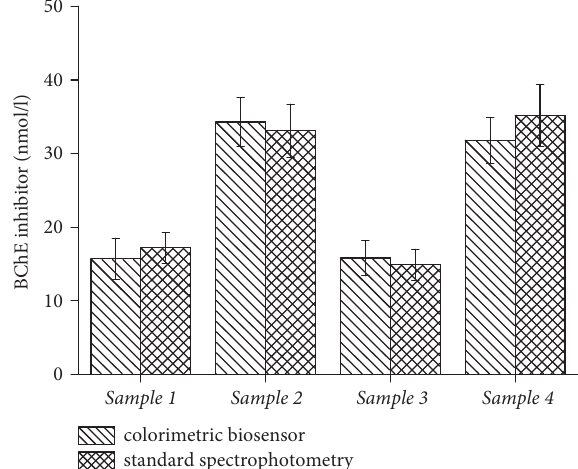
Figure 9: Comparison of standard spectrophotometric assays and colorimetric biosensor for measuring of cholinesterase neurotoxic inhibitor concentration. Sample 1 contained carbofuran 16nmol/l, sample 2 carbofuran 32nmol/l, sample 3 paraoxon ethyl 16nmol/l, and sample 4 paraoxon ethyl 32nmol/l. Standard error of the mean is depicted for five independent repeats ( n �